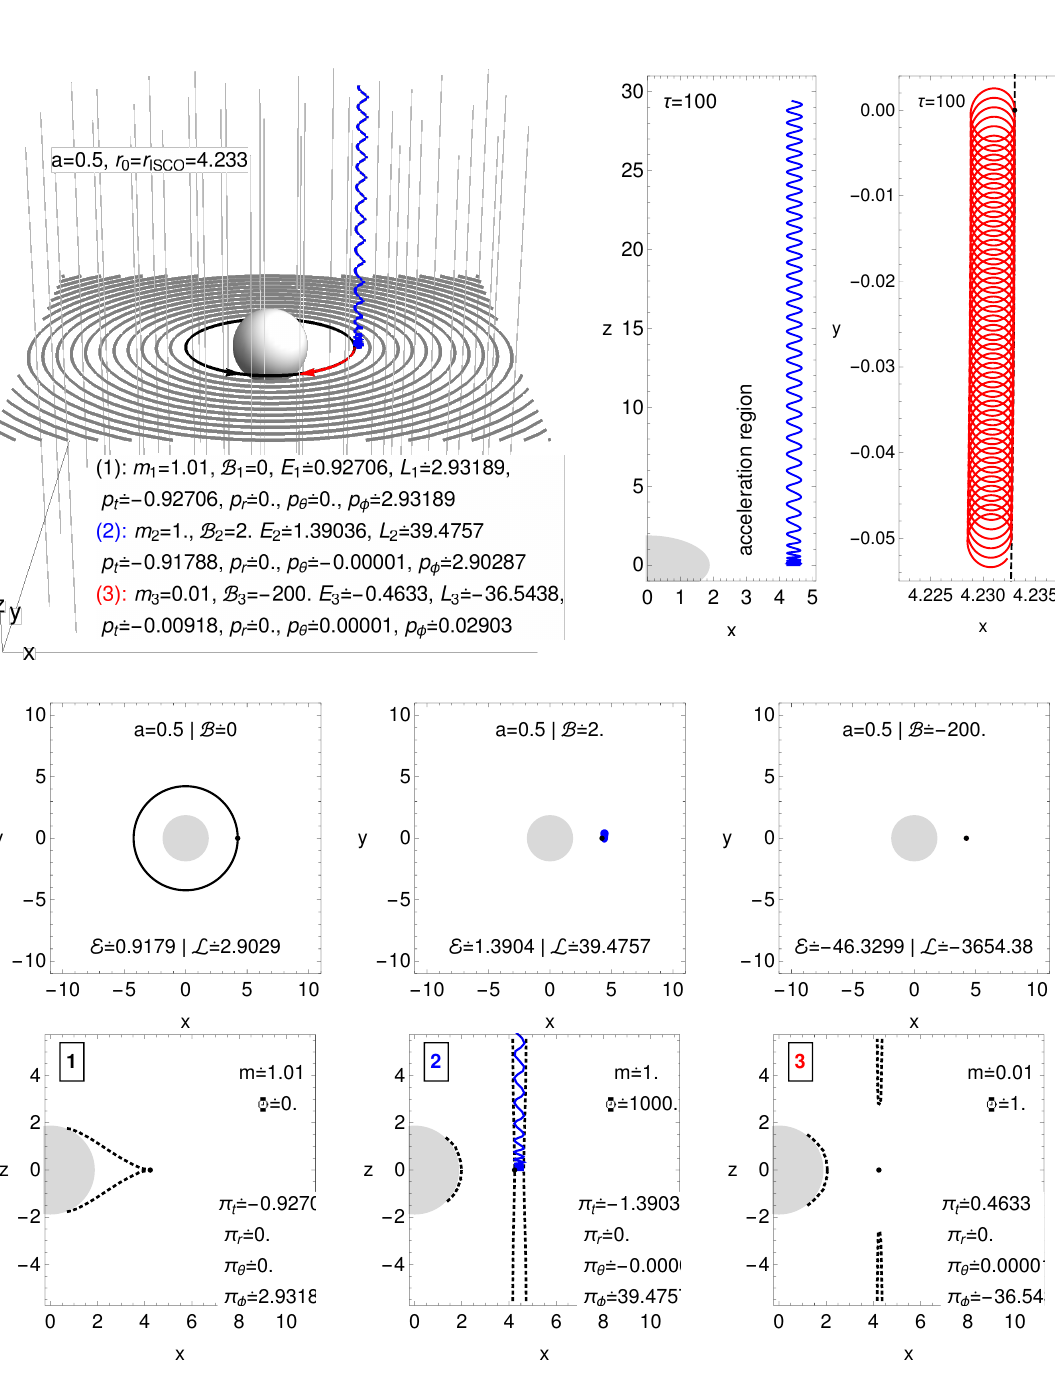
Figure 16. Particle acceleration in the vicinity of a magnetized rotating black hole —1st neutral particle (black, neutron) has been located on accretion disk inner edge, decaying into two charged particles, 2nd (blue, proton), and 3rd (red, electron). While the 3rd particle (red) is trapped with large negative energy on orbits around black hole, the 2nd (blue) gets large energy due to the so-called chaotic scattering escapes along the magnetic field